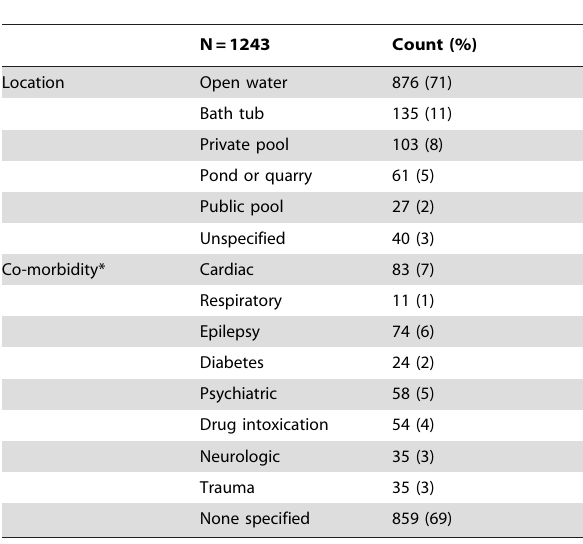
Table 2. Location of drowning and medical